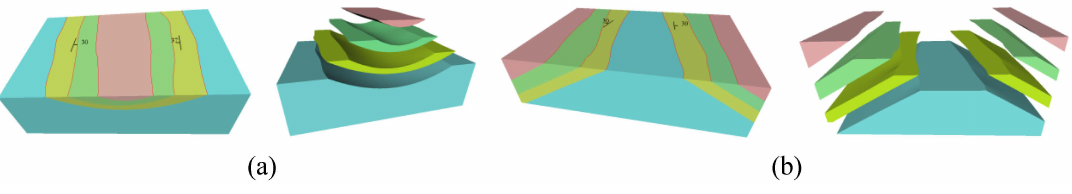
Figure 8. Simulated folds: ( a ) syncline and ( b ) anticline.